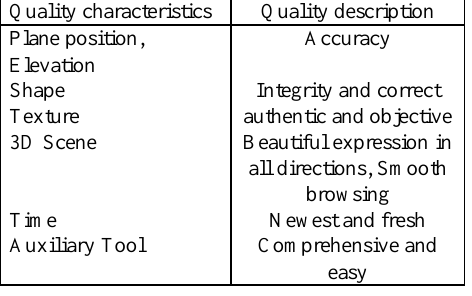
Table 1 . Main quality characteristics.